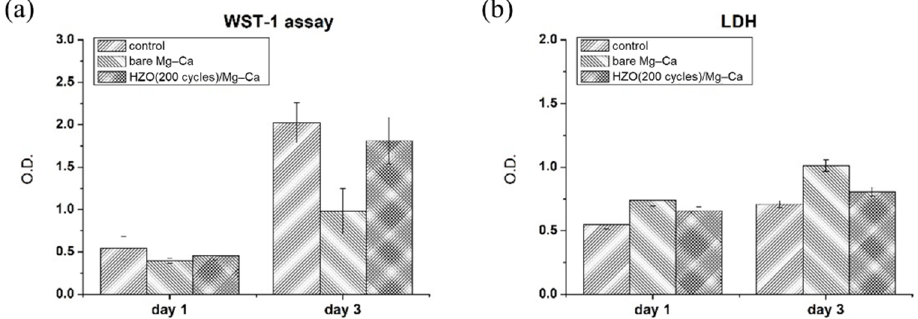
Figure 11. The cytotoxicity of bare Mg–Ca alloy and HZO(200 cycles)/Mg–Ca. ( a ) WST-1 assay to test mitochondrial activity and ( b ) LDH concentration to analyze cell viability and death.